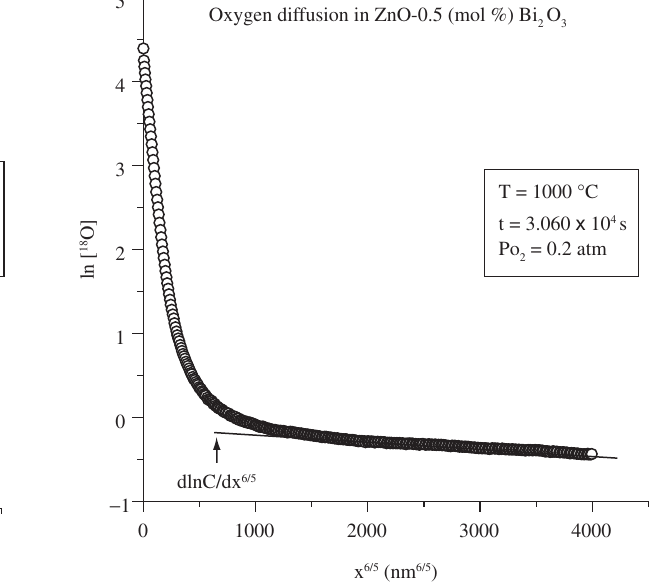
O after diffusion Figure 3. Oxygen concentration plot against x 6/5 for oxygen diffusion in ZnO- 2 3 0.5 mol % Bi O at 1000 °C (same experiment than in Figure 2). The slope 2 3 of the straight line corresponds to the gradient dlnC/dx 6/5 .